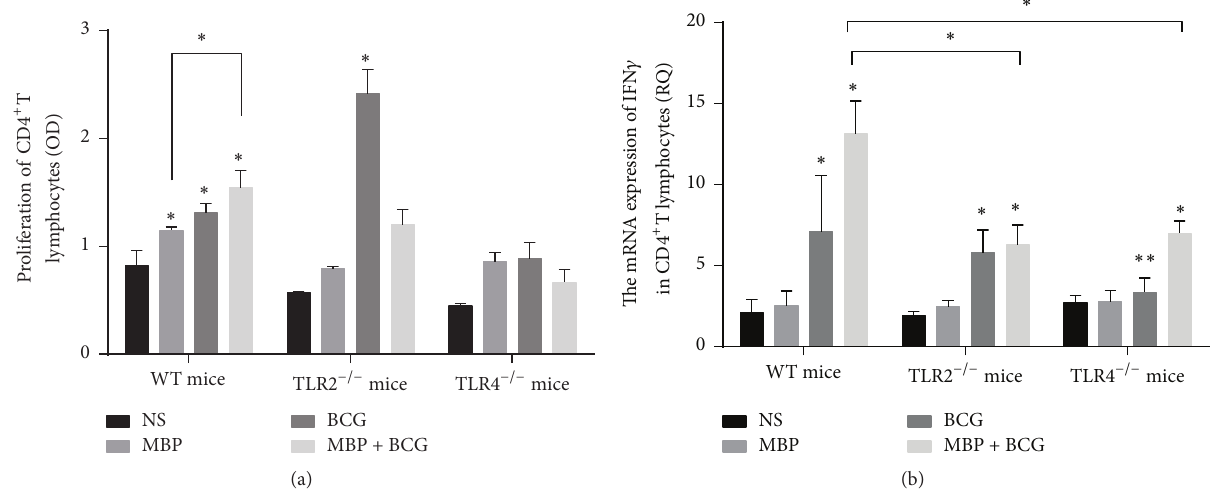
Figure 9: The effect of TLR2/TLR4 expression on the activation of CD4 + T cells induced by the combination of MBP and BCG in vivo. (a) CCK8 assays were used to analyze the proliferation of CD4 + T cells from different types of mice immunized with MBP, BCG, or the combination of MBP and BCG. (b) CD4 + T cells were isolated from WT mice, TLR2 −/− mice, or TLR4 −/− mice immunized with MBP, BCG, or the combination of MBP and BCG, respectively. The mRNA levels of IFN- 𝛾 in the CD4 + T cells from these groups were measured with RT- PCR. ∗ 𝑃 < 0.05 is considered to indicate statistically significant differences compared with the NS group derived from WT mice. ∗∗ 𝑃 < 0.05 , compared with BCG group from different types of